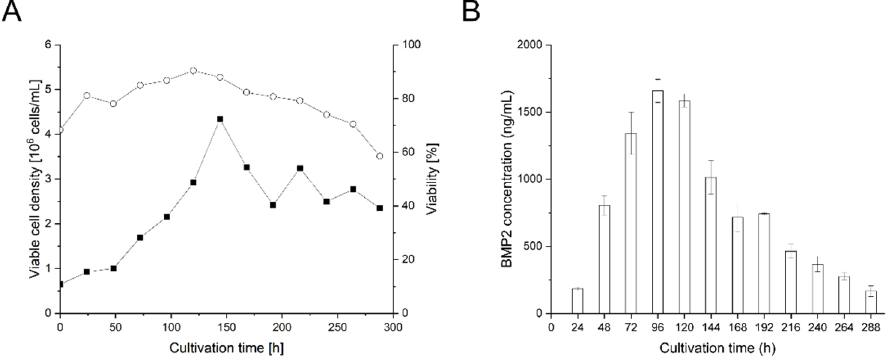
Figure 2. Transient BMP2 production in HEK sus spinner cultivations after small-scale HCD transient transfection. ( A ) Viable cell density ( (cid:4) ) and viability ( ) (n = 1). ( B ) BMP2 concentration measured transfection. ( A ) Viable cell density ( ■ ) and viability ( ○ ) (n = 1). ( B ) BMP2 concentration measured (cid:35) by ELISA (mean value ± SD, n = 5 technical by ELISA (mean value ±SD, n = 5 technical replicates).